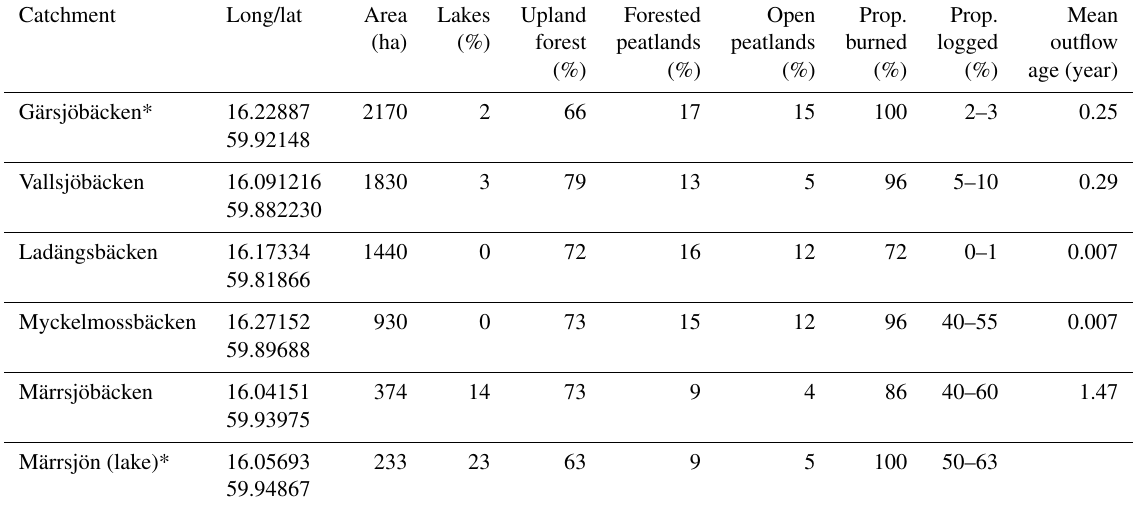
Table 1. Overview of the burned catchments, their land characteristics, and annual mean outflow water age (2014 August–2015 July). The last catchment (Märrsjön) is a lake catchment. Proportion logged is based on estimated salvage-logged area during the first year after the fire. Longitude and latitude (WGS84) indicate the sampling location. See also the map in Fig. 1. Long-term monitoring catchments are indicated with an asterisk